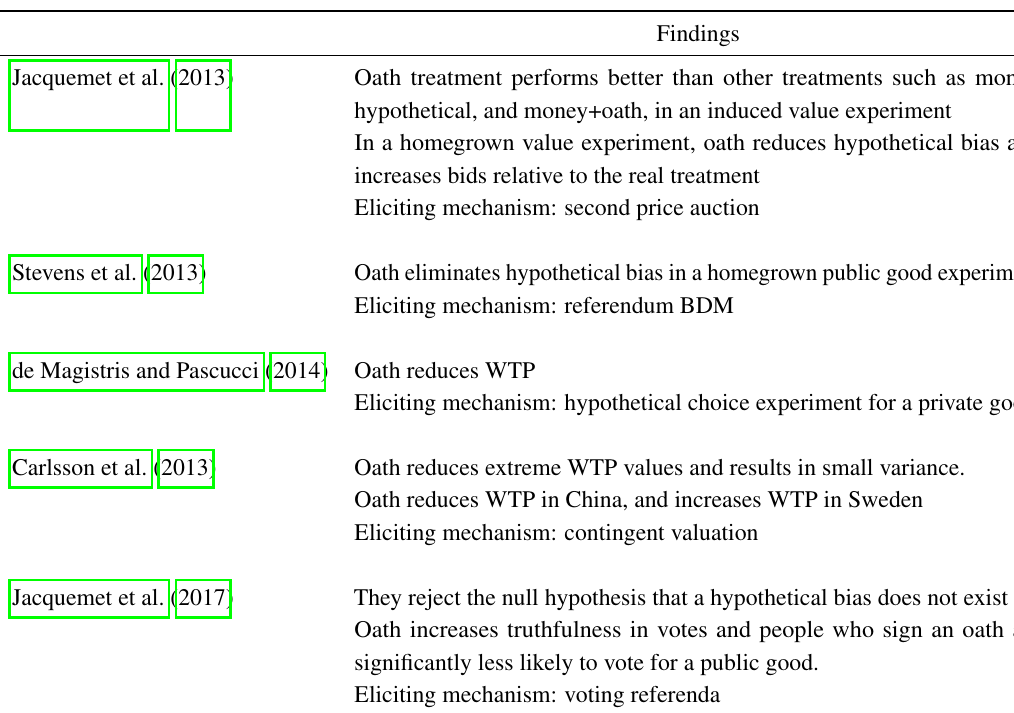
Table 1: Oath and environmental